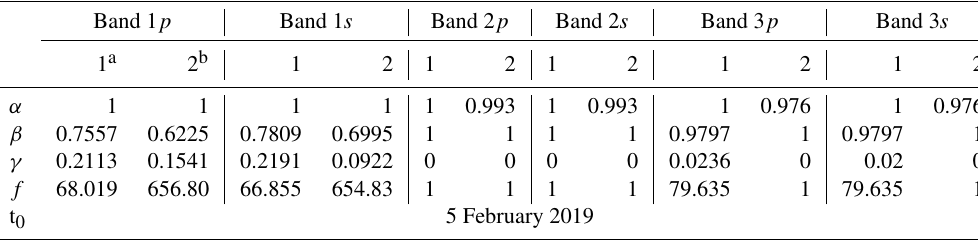
Table 6. Radiometric correction parameters as a function of time since launch.